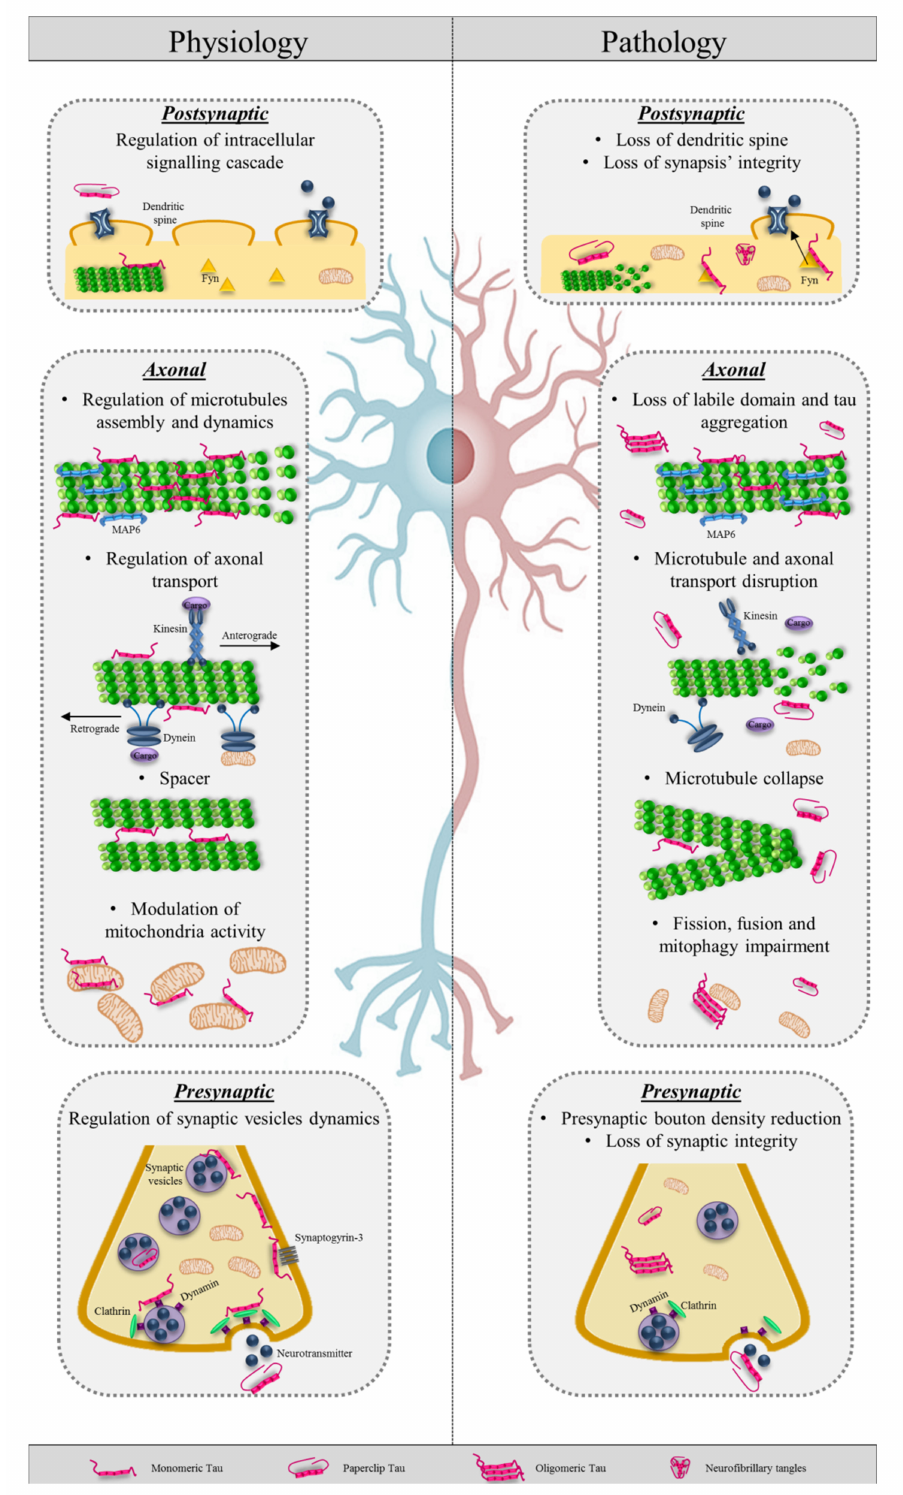
Figure 2. Tau protein in physiology and pathology. On the left, schematic representation of physiological tau functions at postsynaptic, axonal, and presynaptic level. On the right, pathological e ff ects of abnormal (oligomeric and neurofibrillary tangles) tau in the three cellular compartments. Finally, at axonal level, tau can act as a sca ff olding protein: tau interacts with kinases and phosphatases such as PP1 [52], GSK3 β [53], cyclin-dependent kinase 5 (Cdk5) [54],